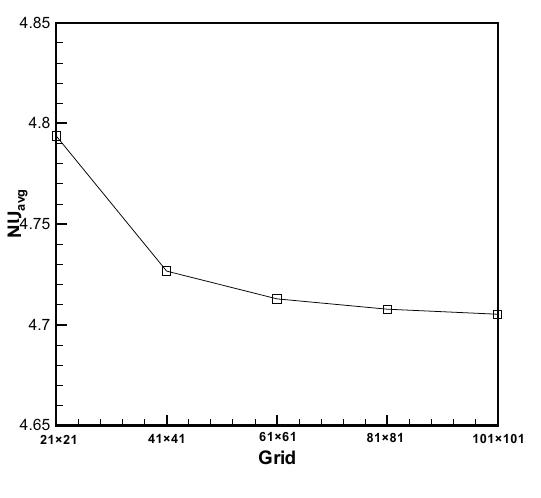
Fig. 2: Average Nusselt number for different mesh sizes at Ri = 100 ,